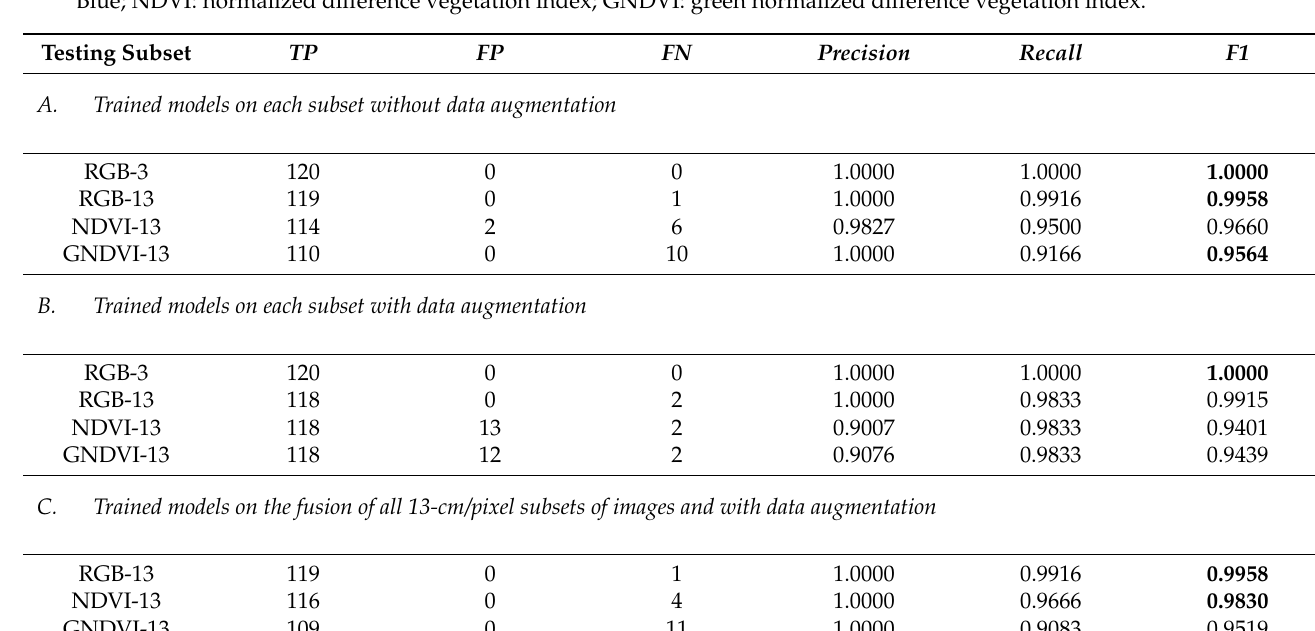
Table 3. Segmentation performance of Mask R-CNN models for “Olive tree crown” class applied to the four subsets of the OTCSS-dataset in terms of Precision , Recall and F1-measure. TP : True Positive; FP : False Positive; FN: False Negative. The testing datasets were: RGB-3 cm/pixel, RGB-13 cm/pixel, NDVI-13 cm/pixel, and GNDVI-13 cm/pixel. RGB: Red, Green, Blue; NDVI: normalized difference vegetation index; GNDVI: green normalized difference vegetation index.